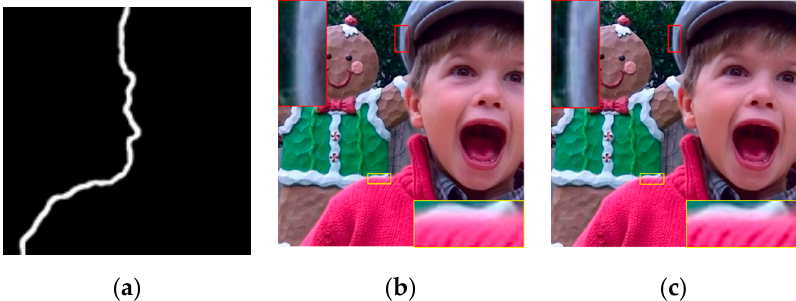
Figure 5. ( a ) The transitional area R ; ( b ) the fused image (cid:101) I F based on the final decision map; ( c ) the final fused image I F .